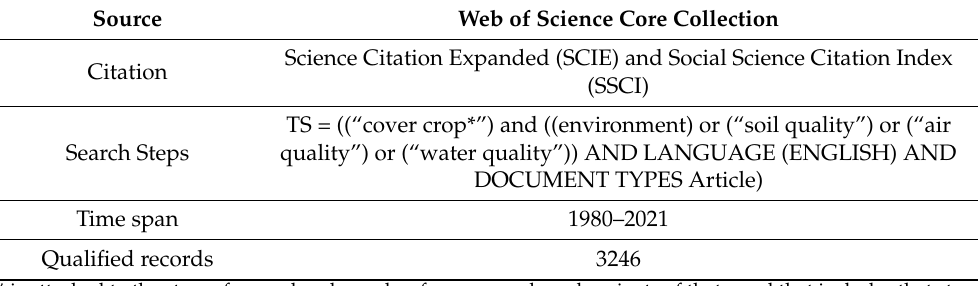
Table 1. Detailed search setting